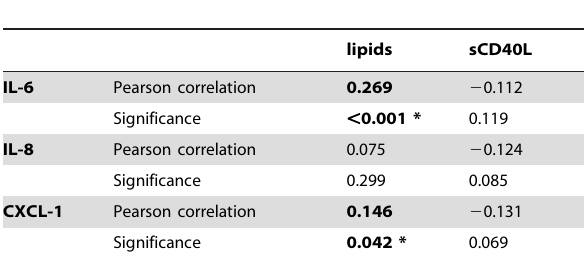
Table 1. Correlation of inflammatory mediator release in endothelial cells with baseline sCD40 and lipid concentration in blood